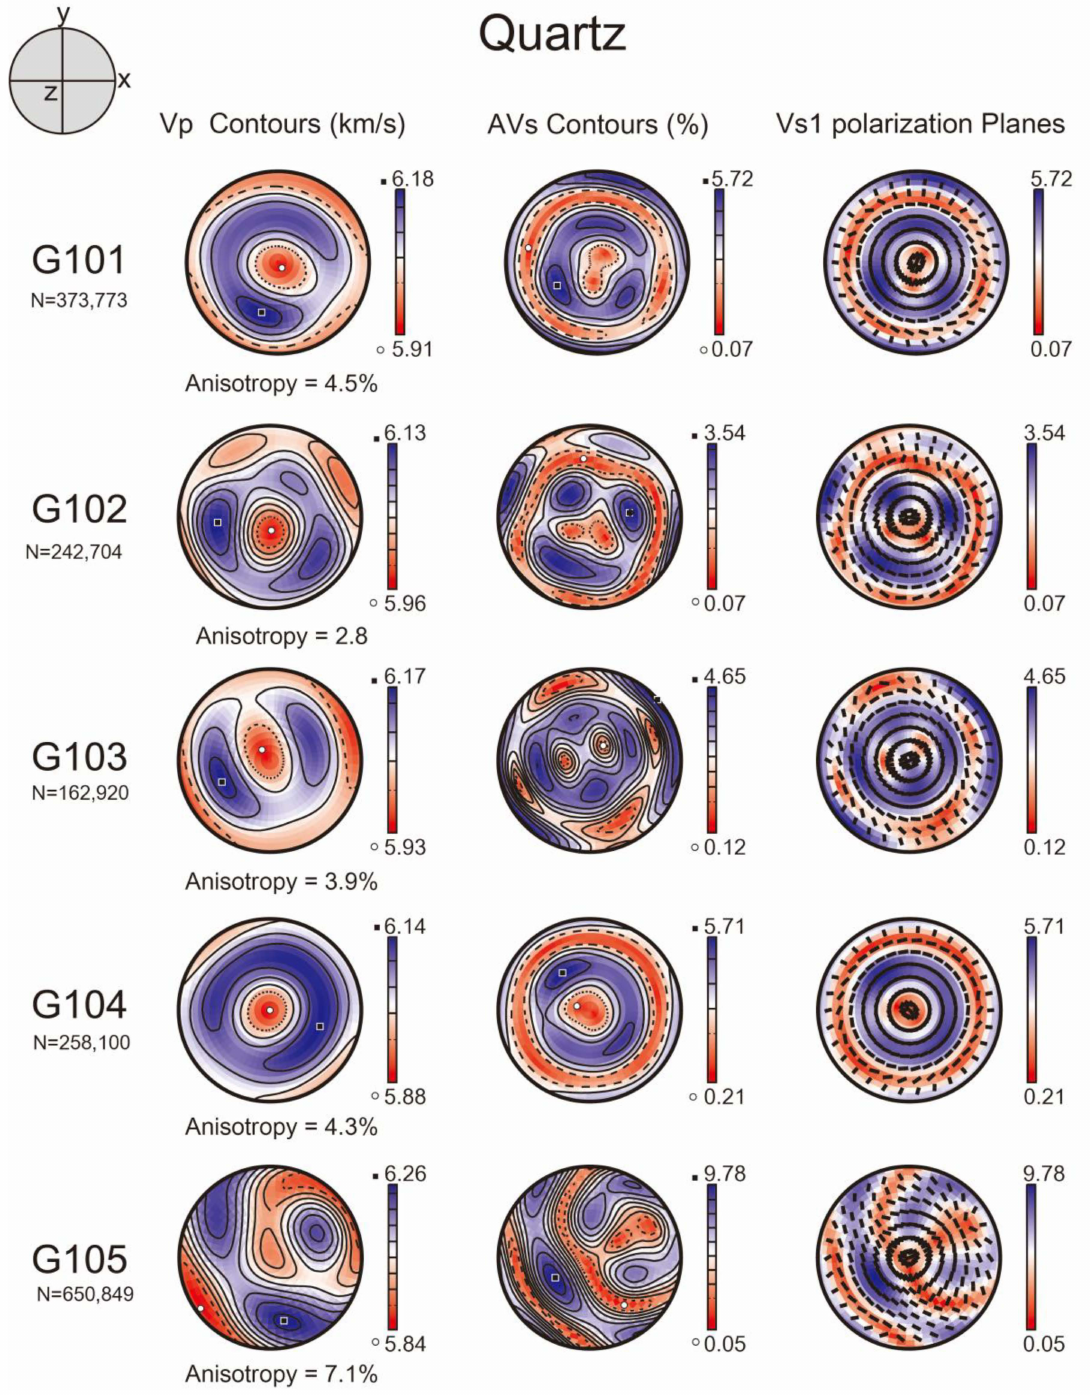
Figure 8. Seismic properties of quartz calculated from LPO and elastic constant. The P-wave velocity (Vp), amplitude of the shear-wave anisotropy (AVs), and polarization direction of the faster shear wave (Vs1) are plotted in the lower hemisphere using an equal-area projection. E–W direction of each figure corresponds to stretching lineation (X), and Z is normal to the foliation. N = number of data